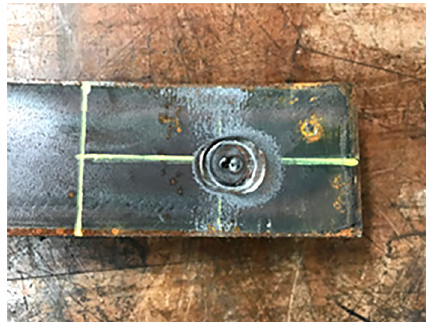
Figure 13. Surface of the steel coupon after the tensile Figure 11. Loading and measuring devices (unit: